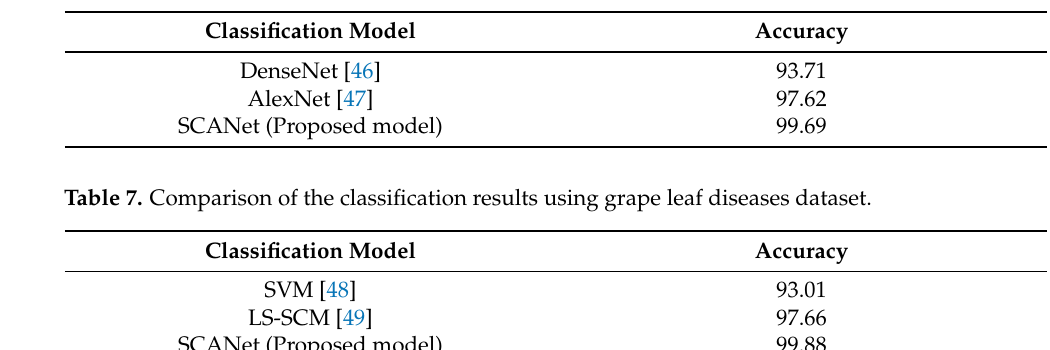
Table 6. Comparison of the classification results using apple leaf diseases dataset.